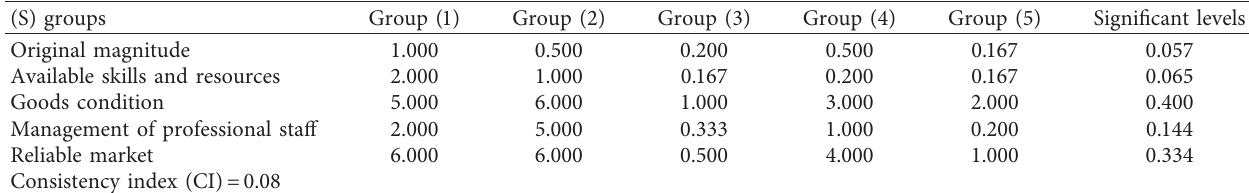
Table 5: Analogy matrix of (S)